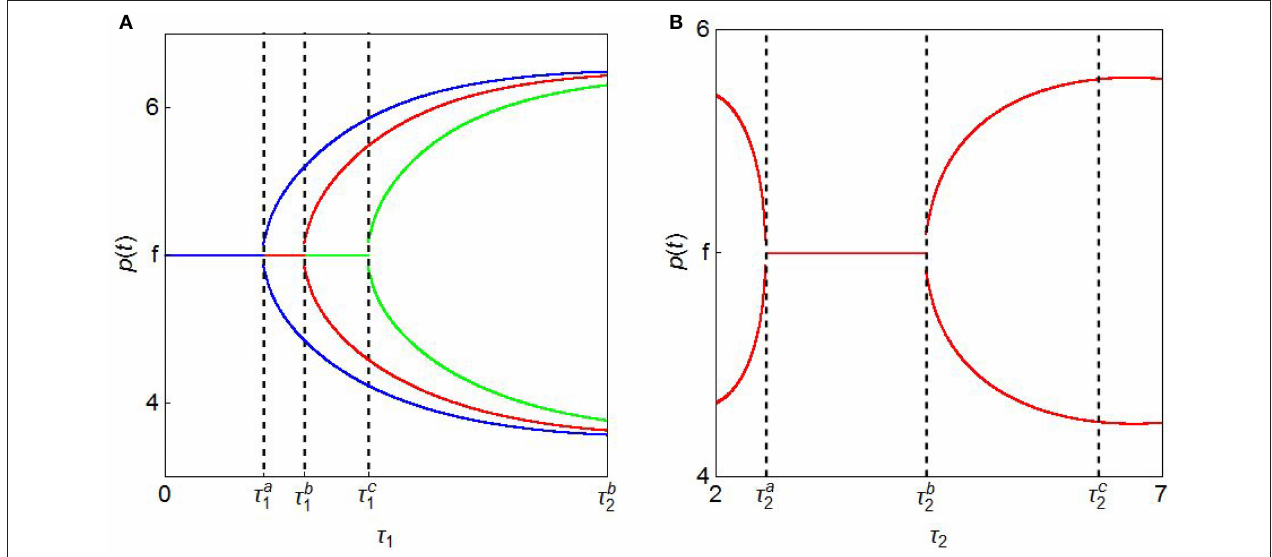
FIGURE 7 | Delay effects on dynamics: (A) τ 1 -effect; (B) τ 2 -effect.